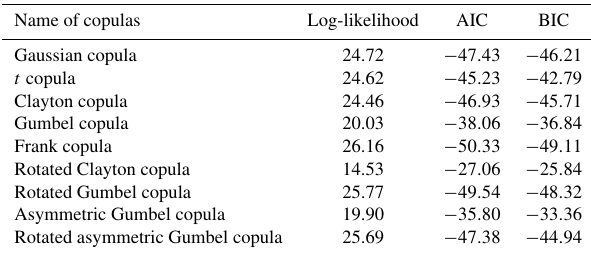
Table 8. Occurrence probability weights of each source of the Sagami Trough earthquake (NIED,